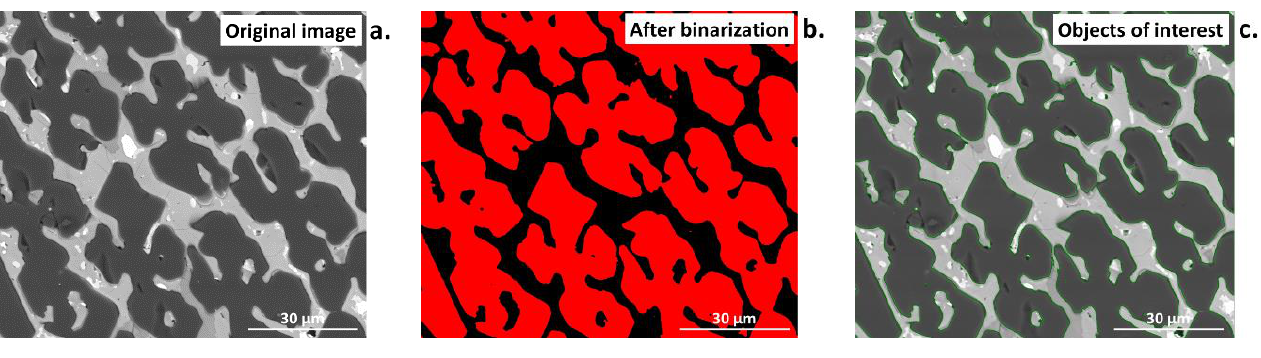
Figure 10. Comparison of ( a ) the original microstructural image of ceramic material with the image ( b ) after binarization, ( c ) comparison of images with marked objects of interest (green) permits for the visual assessment of the quality of the binarization.